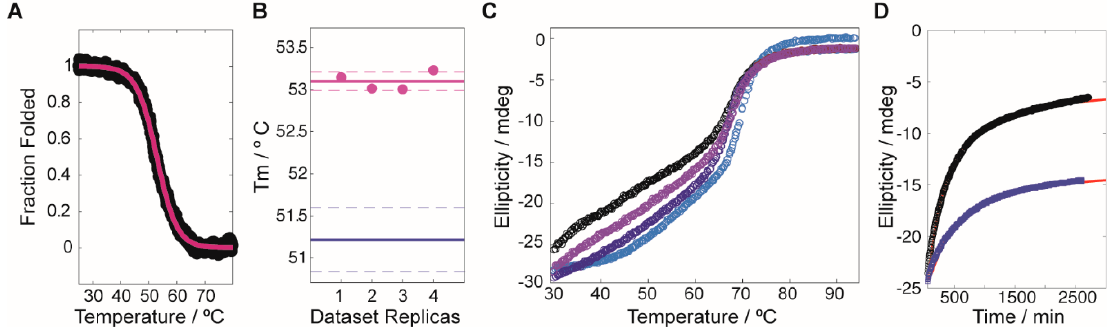
Figure 1. Compound induced stability experiments on fumarylacetoacetate hydrolase (FAH). ( A ) Typical profile for the stability screening, where the black circles correspond to the experimental data (converted to fraction folded) and the red line is the best fit to the dataset. ( B ) Reproducibility of the Tm values obtained by using the linear extrapolation model on the sigmoidal decays. The purple circles correspond to the experimental data, with an average value/uncertainty represented by the solid/dashed lines. Equivalent values for the reference protein (in the absence of compound) are shown in blue. ( C ) Thermal denaturation experiment for WT-FAH in the absence (black circles) and in the presence of increasing concentrations of the compound G1.30.B10 (light purple, 15 eq.; dark purple, 30 eq.; blue, 45 eq.). ( D ) Aggregation tendency of V166G-FAH over time (monitored by the ellipticity at 222 nm), in the absence (black circles) and in the presence (blue squares) of 15 eq. of G1.30.B10. The red lines correspond to the best exponential fittings to the experimental datasets.